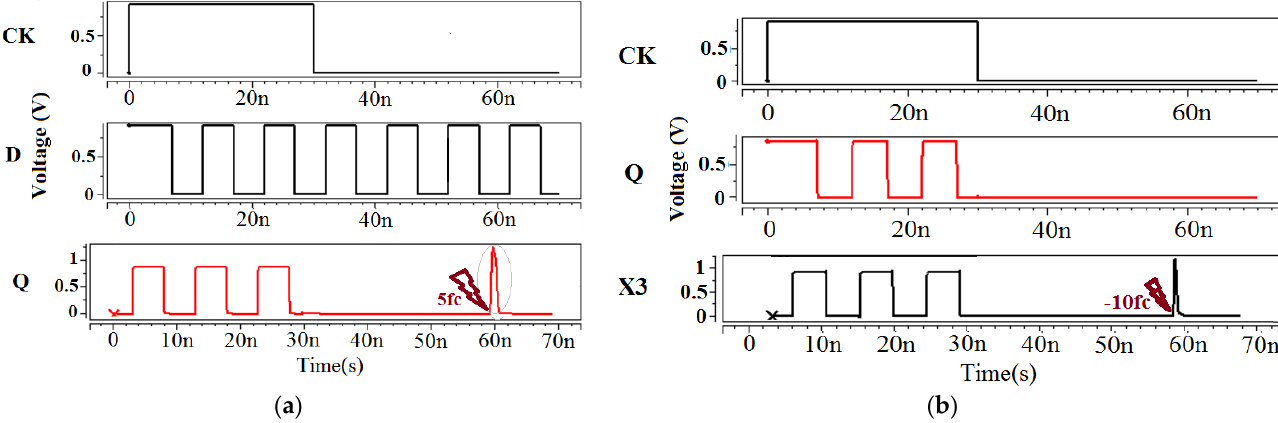
Figure 4. Test results for a positive and negative SEU injections to nodes when the output is “0” during the holding time: ( a ) to “ Q ” node; ( b ) to “X3” node.